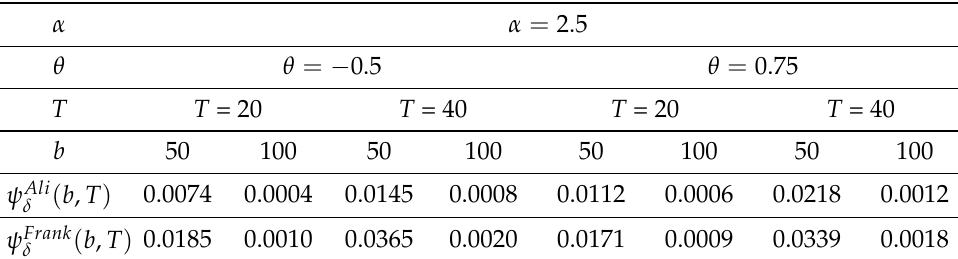
Table 1. Asymptotic finite-time ruin probability for homogeneous Poisson risk model with inter- est rate.